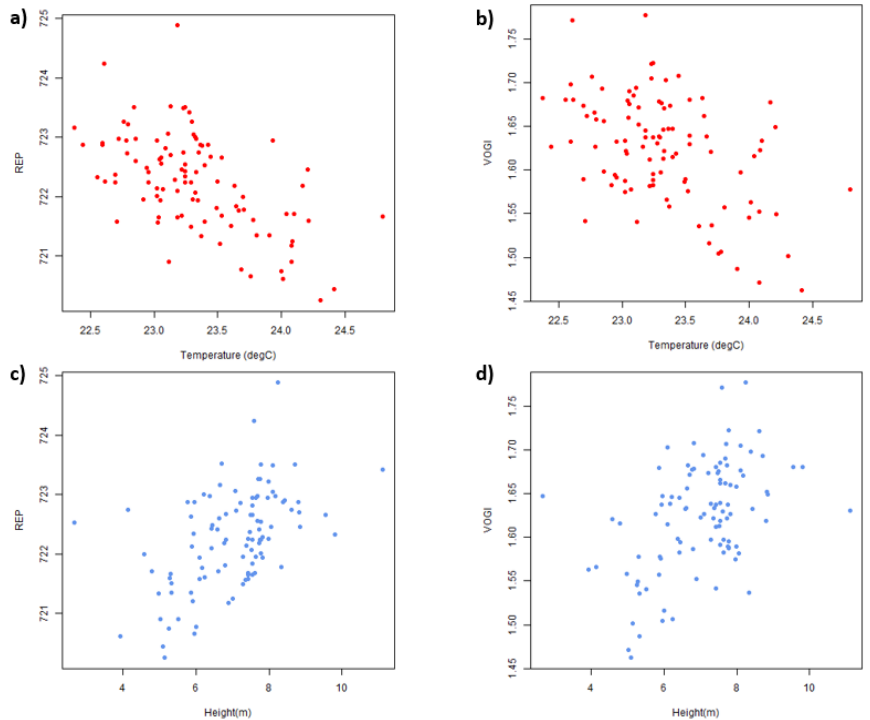
Figure 10. Correlation analysis for 100 test trees in Block 11: ( a ) and ( b ) show the correlation between temperature and two selected VIs, red-edge position (REP) and Vogelmann red edge index (VOGI), and ( c ) and ( d ) show the relationship between these indices and height.